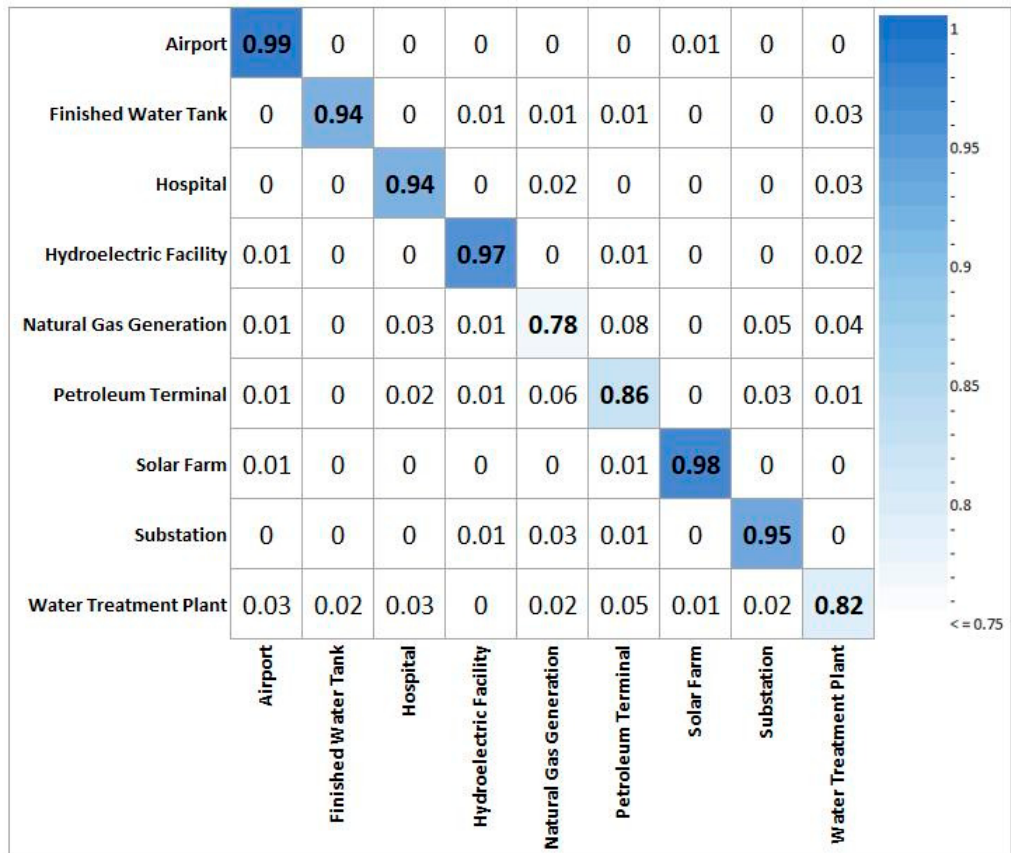
Figure 4. Confusion matrix for the nine CI facility types.